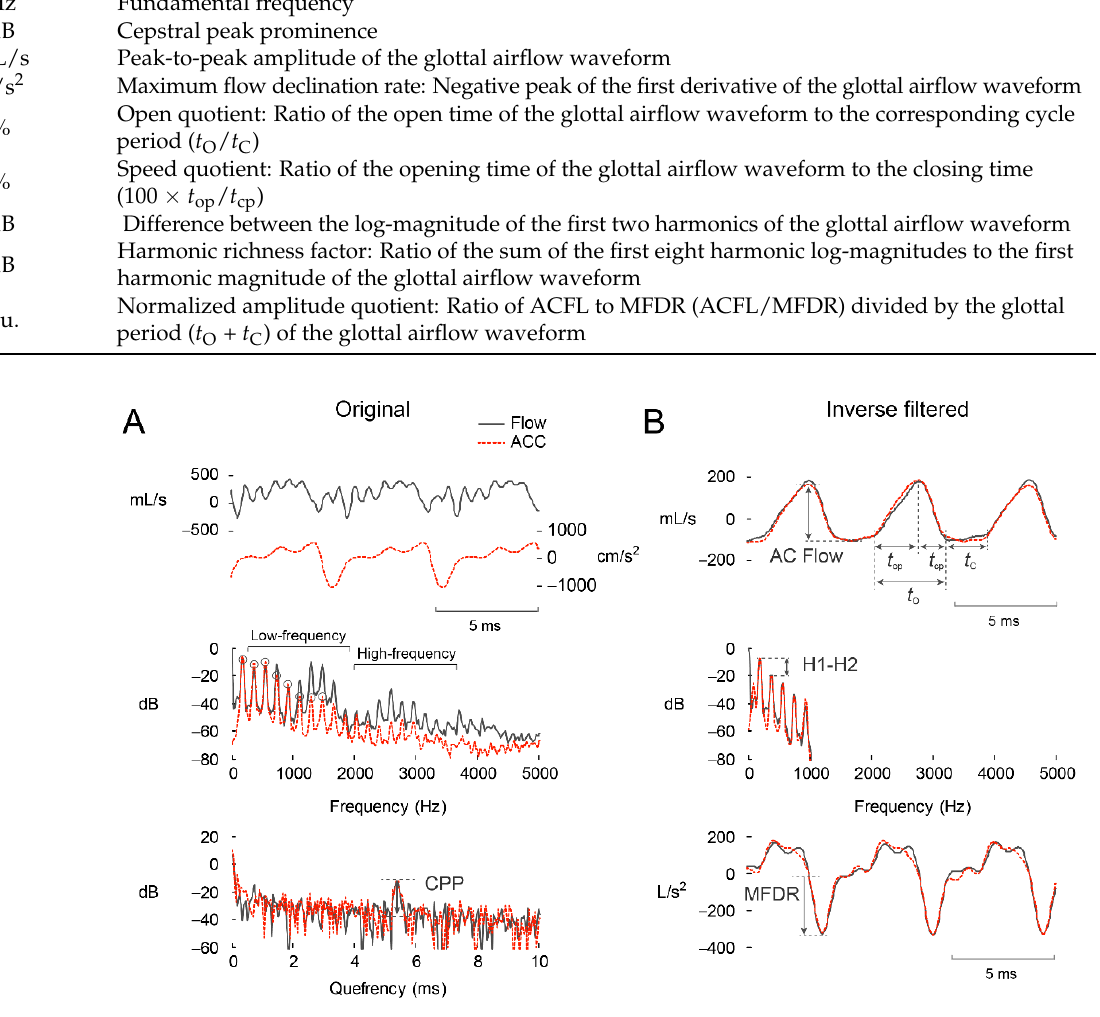
Figure 3. Feature extraction completed for the ( A ) originally recorded signals and ( B ) inverse-filtered versions of the oral airflow waveform (solid black) and neck-surface vibration acceleration (ACC, red-dashed). From [77].